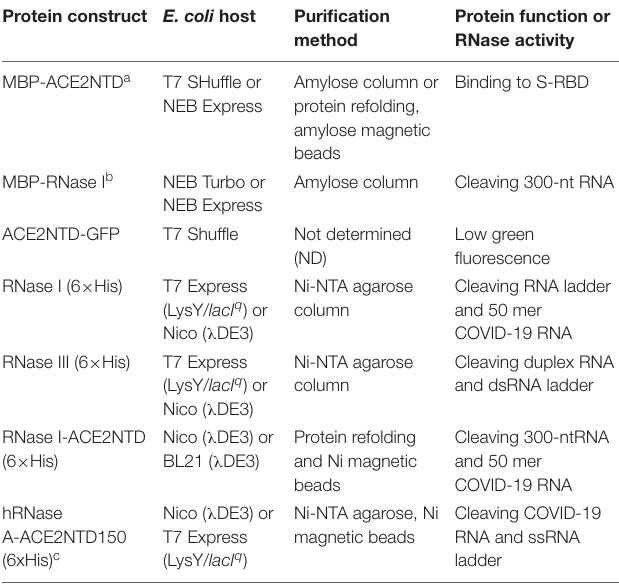
TABLE 1 | Escherichia coli expression strains, purification method, and enzyme activity/potential usage. Protein construct E. coli